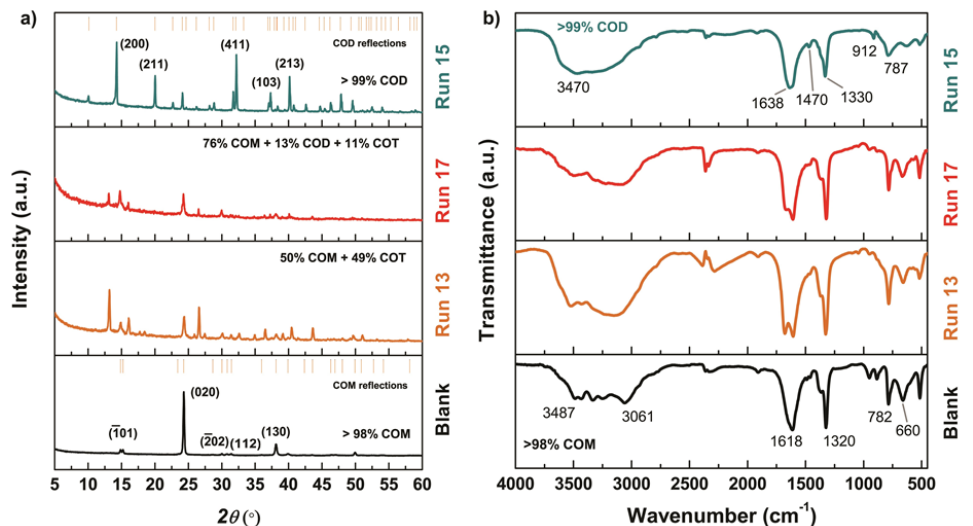
Figure 2. (a ) XRD diffraction diagrams and ( b ) FTIR spectra of precipitated systems; Blank, Run 13, Run 17 and Run 15. The standard diffraction spectra and the main reflections of COD (up) and COM (down) are shown for comparison. The standard vibrations bands for COD (up) and COM (down) are also shown.